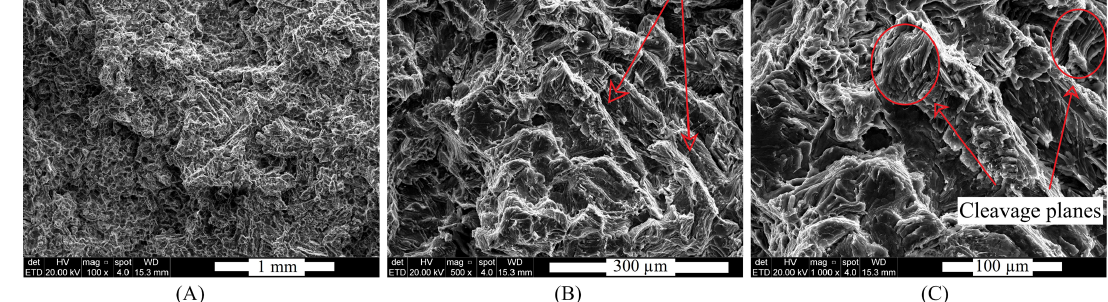
Figure 9. Fracture surface of the slow cooling condition.